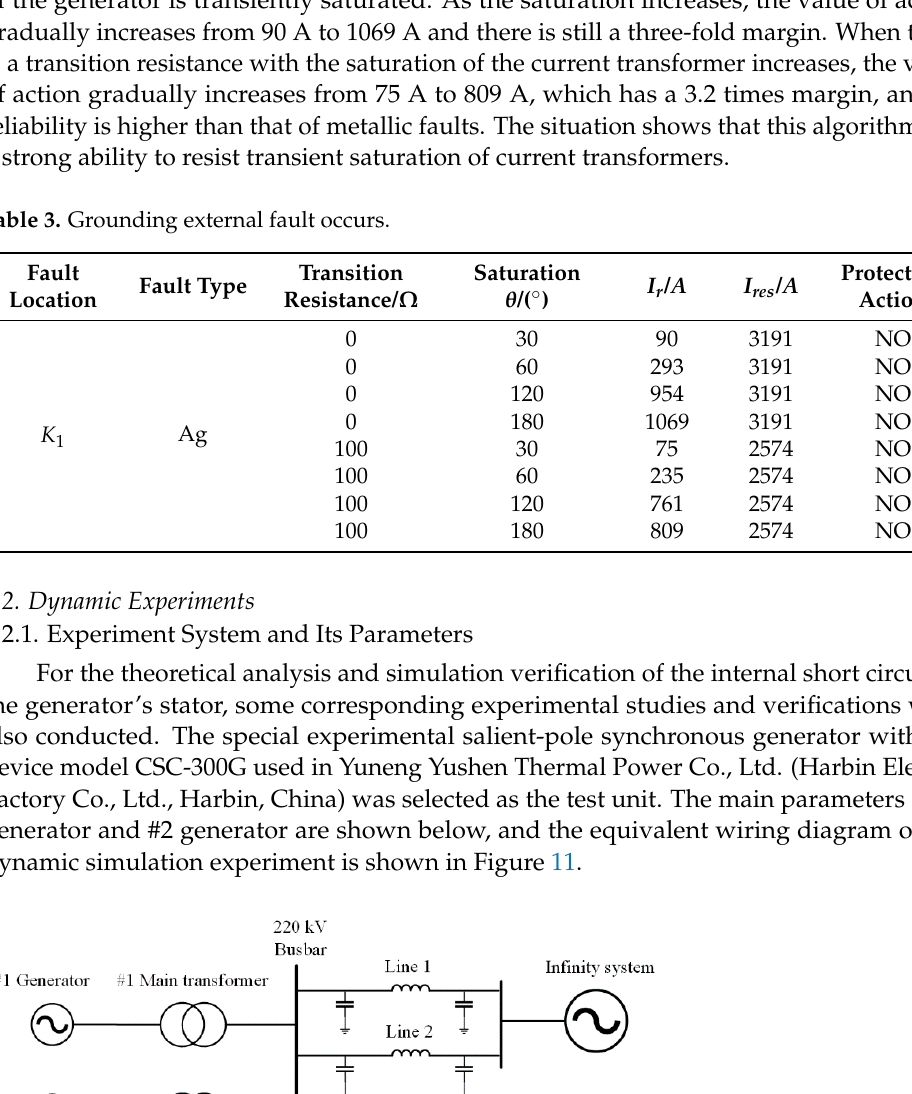
Table 3. Grounding external fault occurs.